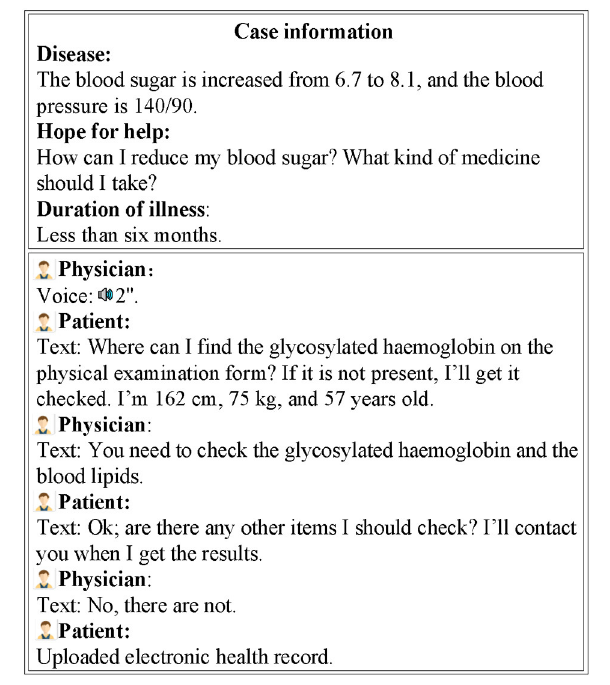
FIGURE 2 | Example of a physician–patient communication record.